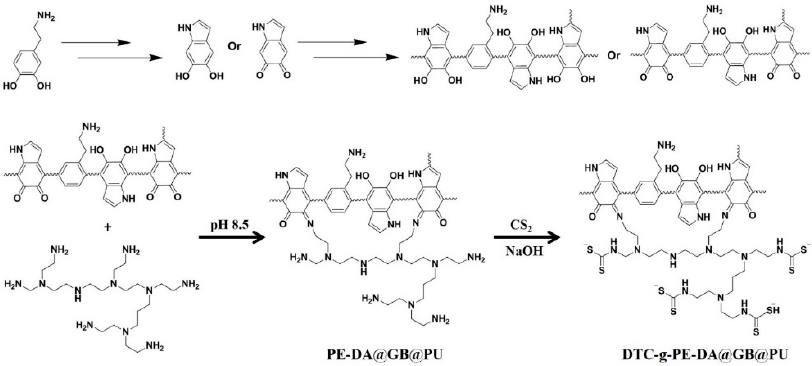
Figure 1. SEM image of ( a ) raw PU, ( b ) APU, ( c ) GB@PU, ( d ) PE-DA@GB@PU, and ( e ) DTC-g-PE- DA@GB@PU, ( f ) magnification SEM image of ( e ). The chemical structures of PU, APU, GB@PU, PE-DA@GB@PU and DTC-g-PE-DA@GB@PU were analyzed by FTIR spectroscopy, and their FTIR spectra are shown in Figure 2. The broadening of the band at 3308 cm − 1 in the spectrum of APU was ascribed to stretching vibration of N–H for PU shifted to 3293 cm − 1 for APU [25]. After graphene coated on the APU skeleton, the peaks of GB@PU between 2700 and 3500 cm − 1 became weaker, because the graphene coating inhibited spectral absorption. Compared to APU and GB@PU, PE-DA@GB@PU showed a new absorption peak at ~1650 cm − 1 and a broad band from 3200 to 3600 cm − 1 . The former could be assigned to the carbonyl groups derived from dopamine oxides, whereas the latter likely corresponded to the stretching vibration of hydroxy or amino groups of dopamine and PE [17]. For DTC-g-PE-DA@GB@PU, the characteristic peak of NH 2 group at 3216 cm − 1 disappeared and a new adsorption band could be observed at 958 cm − 1 , which indicated that the amino groups had reacted with CS 2 . However, the characteristic